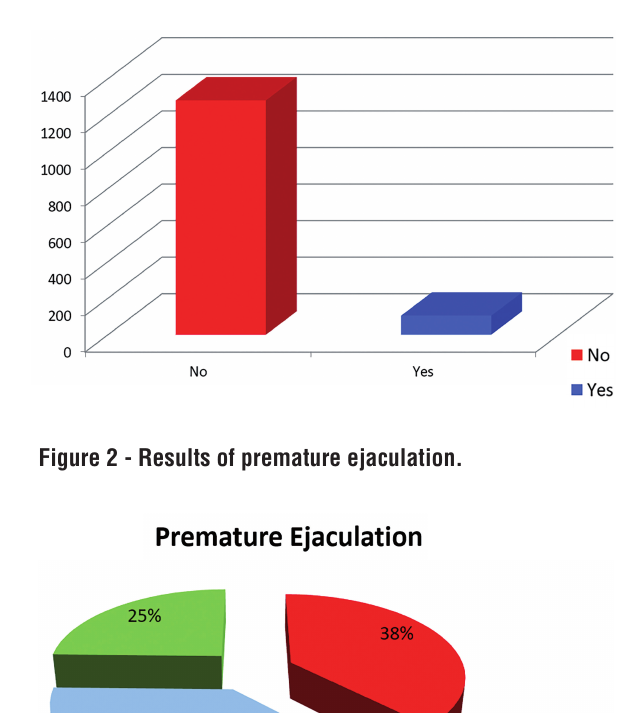
women.Figure 1 - ADAM Questionnaire-Total positive: 92%.